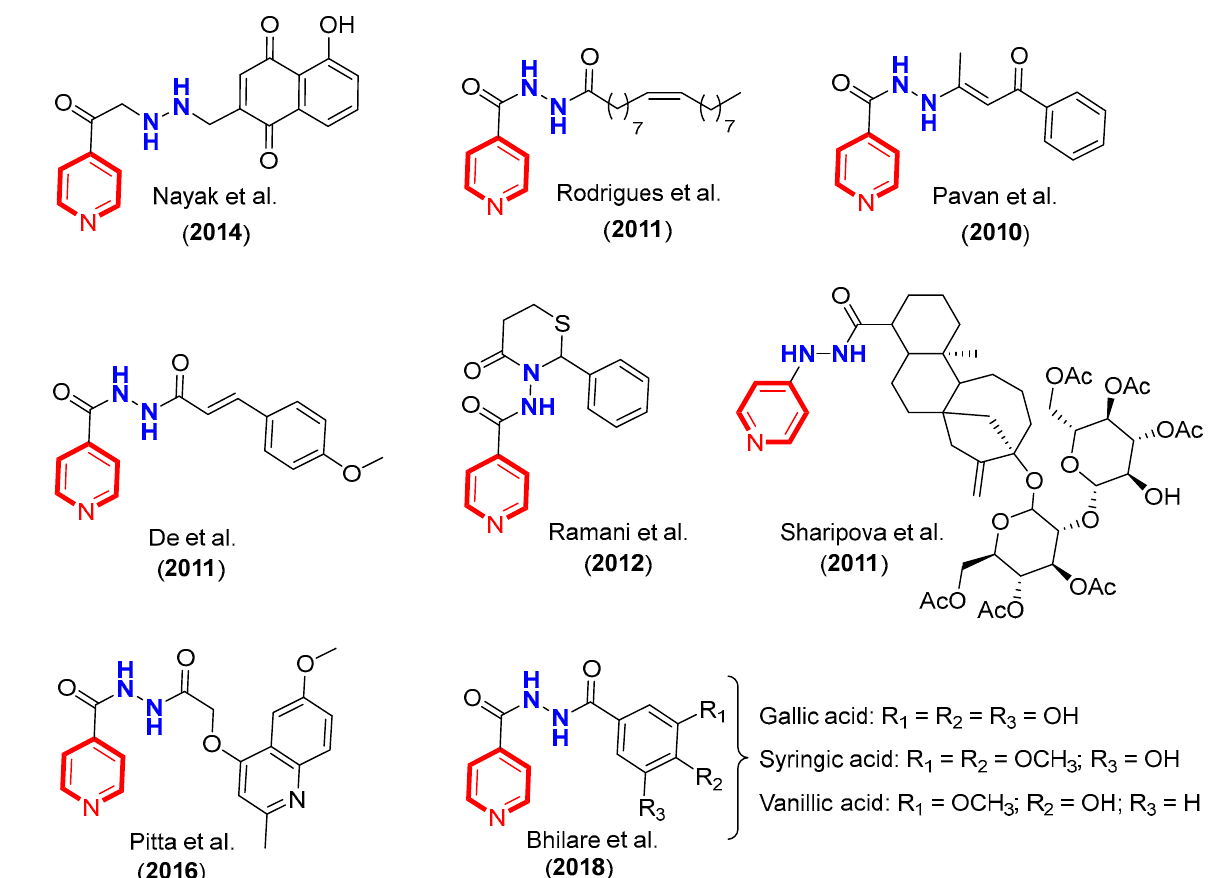
Figure 5. Pyridine and hydrazide containing derivatives of phytochemicals tested against Mycobac- terium tuberculosis .